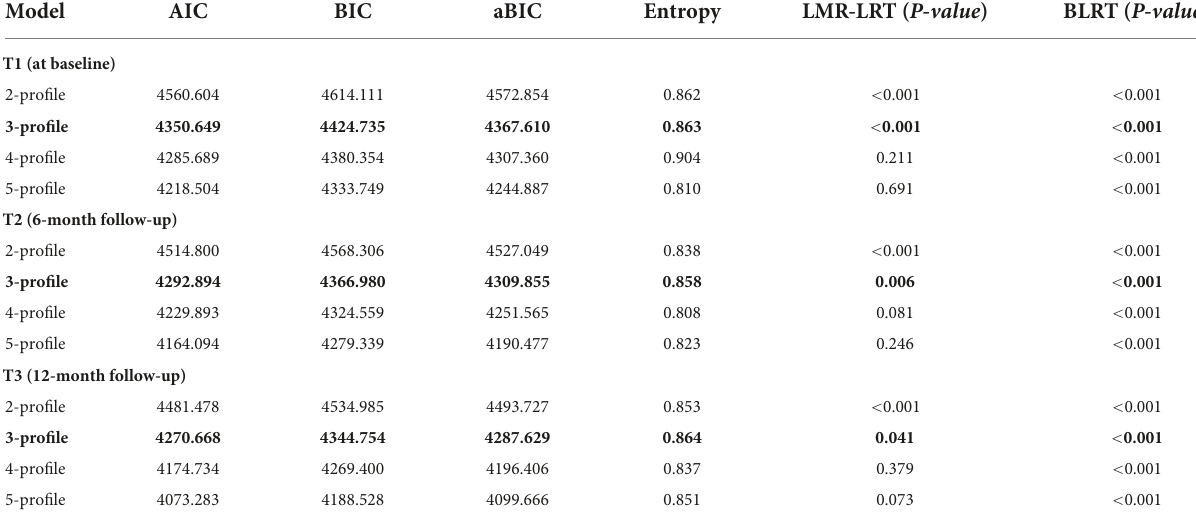
TABLE 1 Model fit statistics for the latent profile models of parental marital conflict and family cohesion at each time point.